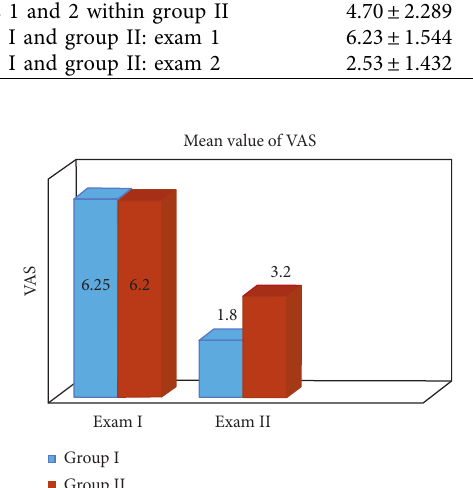
Figure 1: Mean values of the VAS score in two groups obtained in examination I and II (axis